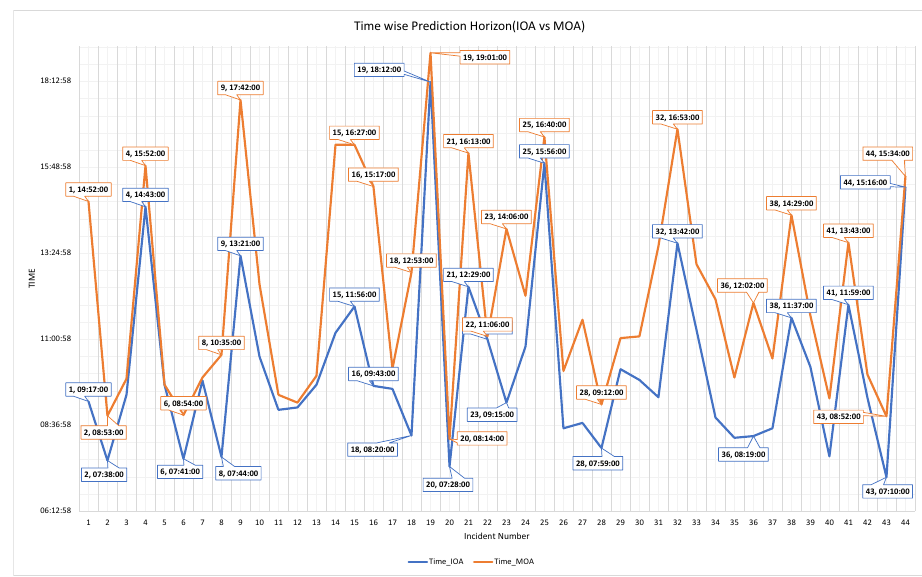
Figure 13. Prediction horizon comparison (MIR opened at vs. incident opened